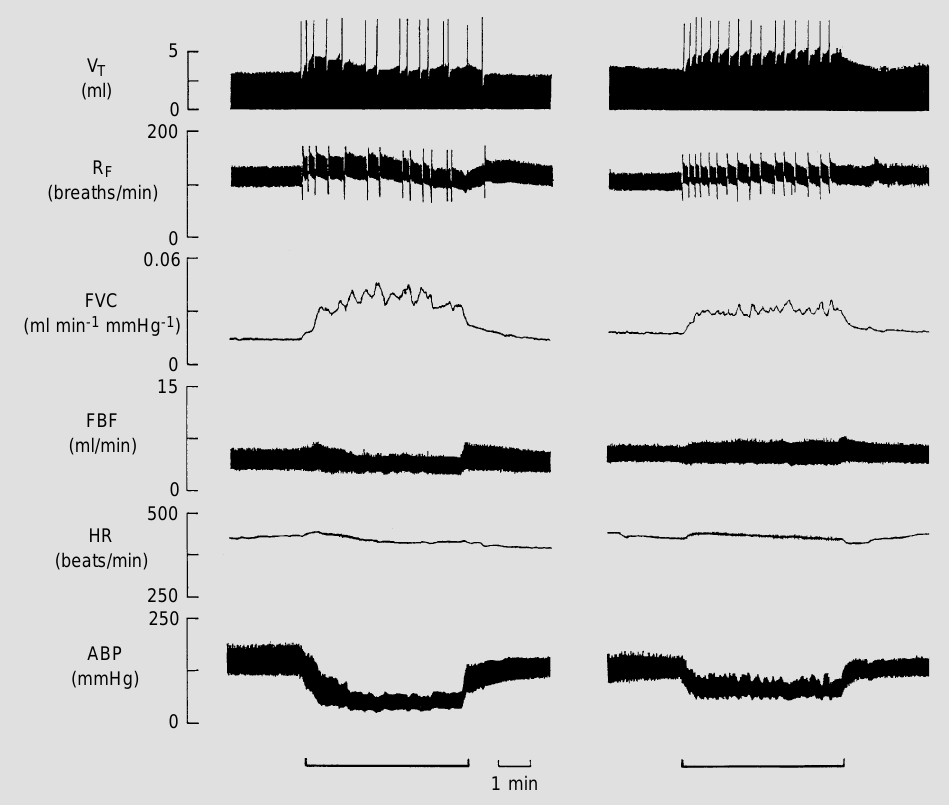
Figure 3 - Original traces show- ing the effect of the adenosine receptor antagonist 8-phenyl- theophylline (8-PT) on the respi- ratory and cardiovascular re- sponses evoked in the anaes- thetised rat by a 5-min period of breathing 8% O 2 . V T , Tidal vol- ume; R F , respiratory frequency; FVC, femoral vascular conduc- tance; FBF, femoral blood flow; HR, heart rate; ABP, arterial blood pressure. 8-PT was given between the left and right hand panels. Note that after 8-PT the V T and HR were better main- tained during hypoxia while the increase in FVC and fall in ABP were